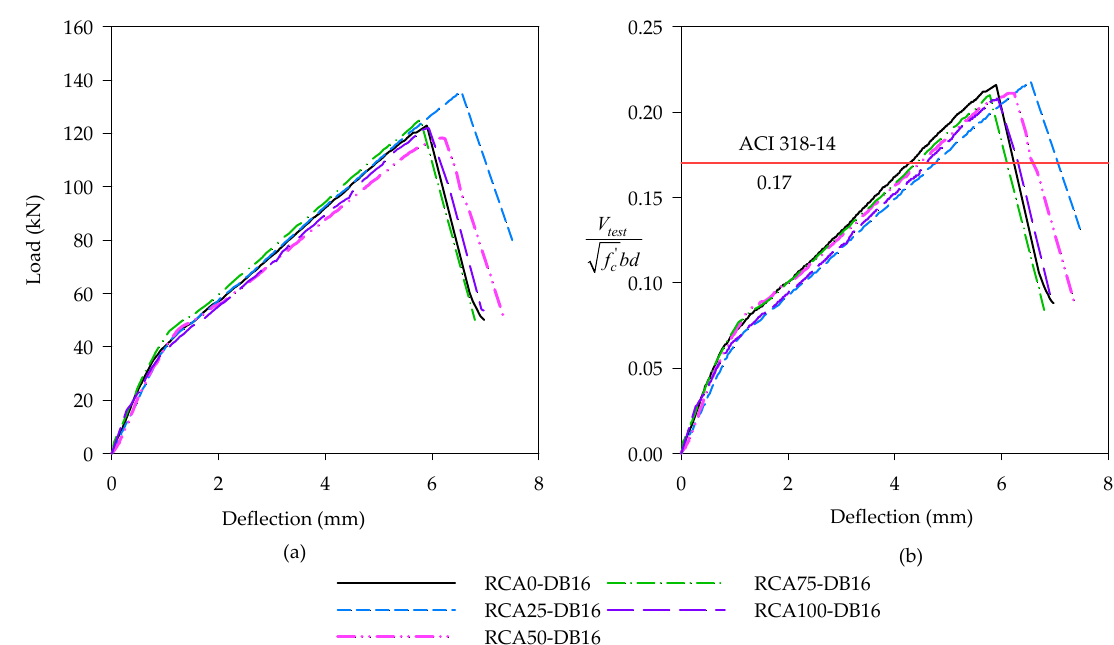
Figure 4. ( a ) Load-deflection curve for beams with reinforcement ratio, ρ w = 1.16%, and ( b ) Normalized shear stress vs. deflection for beams with reinforcement ratio, ρ w = 1.16%.